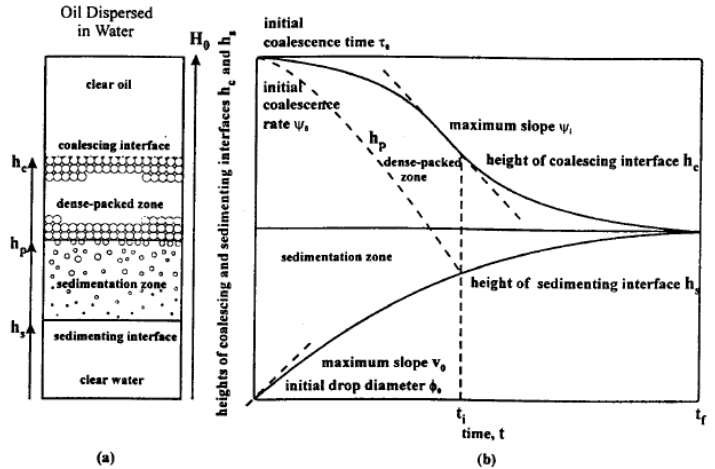
Figure 4. Schematic representation of the settling behavior of a water/oil system ( a ) and the sedimentation and coalescence curve over time ( b ) [26].